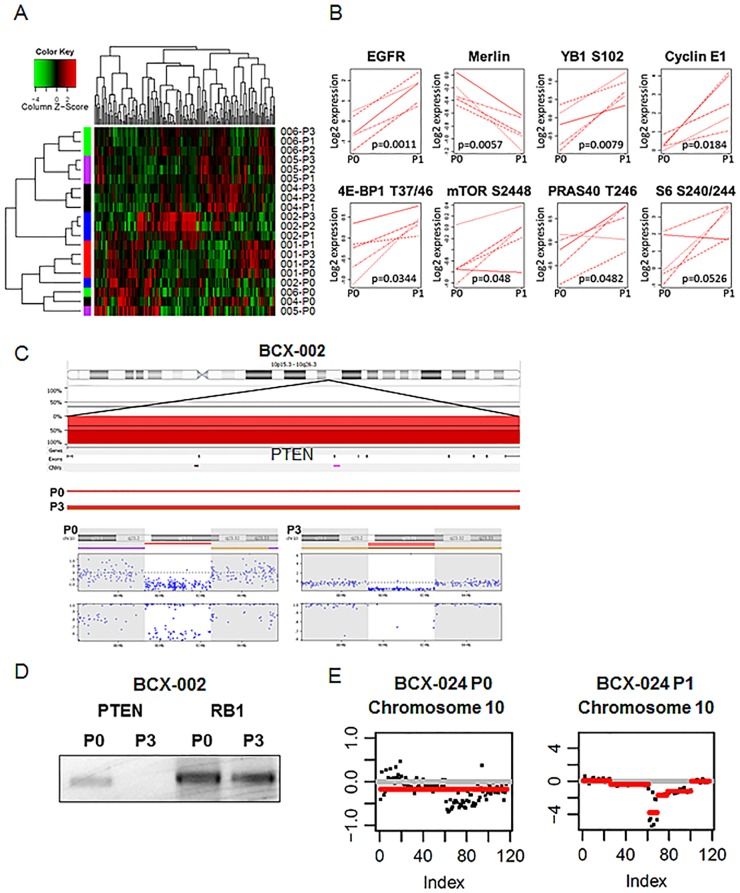
Molecular differences between patients’ tumors and BCXs.(A) Unsupervised clustering of proteomic profile of patient tumors and BCXs as determined by RPPA. Each protein tested represents a column: Red, high expression; green, low expression. Samples are listed on the right side. Left, cluster trees of sample groups; top, cluster trees of proteins. Each BCX model’s P1-3 generation clustered together, demonstrating relative stability of the proteomic profile once growth in mouse is established. However, all P0 generations clustered together, suggesting that differences between patient tumor-xenograft proteomic profiles is greater than inter-tumoral differences. (B) Selected proteins and phosphoproteins that are differentially expressed between patient tumors (P0) and the first-generation of BCXs passaged through nude mice (P1). Protein levels were compared between the two groups with RPPA; all shown have a FDR 0.1 or less. (C) Copy number analysis determined PTEN loss in MDA-BCX-002. Top panel shows the chromosome 10 ideogram and the PTEN gene. Deletions are plotted in red below the 0% baseline, and dark red indicates homozygous loss. The lowest portion of the top panel separates out P0 and P3. A heterozygous PTEN loss is detected in P0, and in the P3, the second PTEN allele is lost, resulting in a homozygous PTEN loss. Bottom panel shows the PTEN gene ideogram followed by the copy number aberration plot and the allele frequency plot for P0 and P3. A heterozygous PTEN loss is detected in P0 (single red line), and a homozygous PTEN loss is detected in P3 (double red line). Each blue dot corresponds to an individual probe on the array. The brown and purple lines mark the thresholds for loss of heterozygosity (LOH) and allelic imbalance regions, respectively. (D) PCR confirmed PTEN deletion in genomic DNA from Patient 2 tumor and BCX-002 P3. PTEN was undetectable in P3 but present in P0. RB1, another tumor suppressor gene, is detected in both samples and included for comparison. (E) PTEN loss demonstrated by next generation sequencing in BCX-024. P0 on the left, P1 on the right.